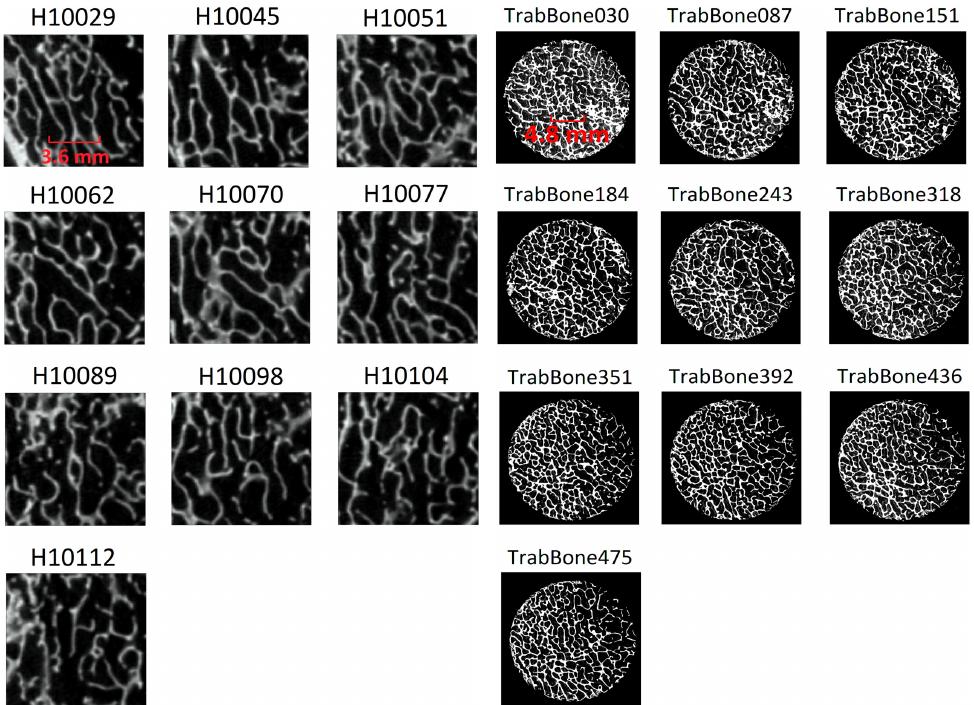
Figure 3. Micro-CT images of bone samples: ( left ) longitudinal slices of one of our bone cubes (male donor of 57 years-old), and ( right ) trabecular bone sample from Doktor et al.